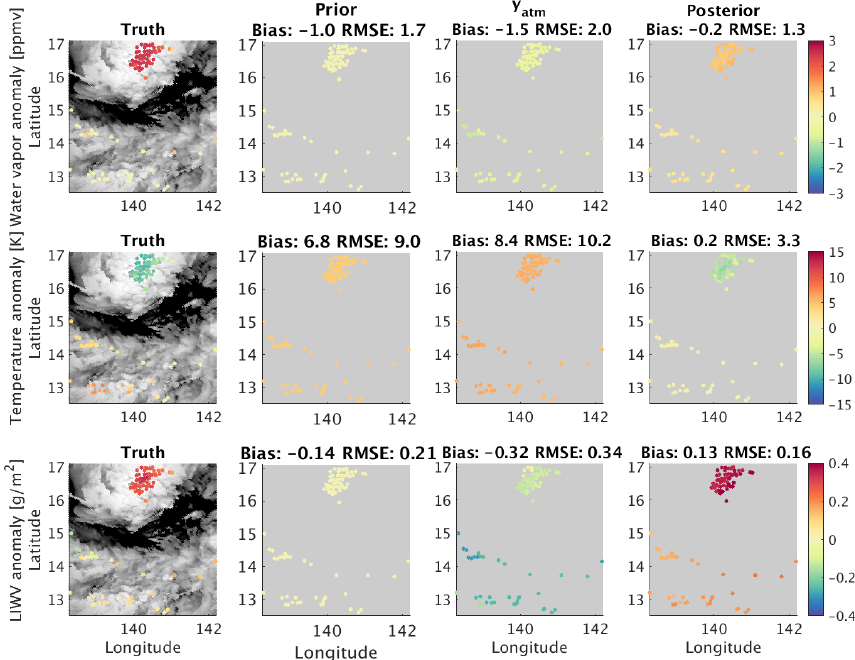
Figure A1. Horizontal distributions of the anomalies, defined as the deviation from the all-sky mean of the simulation field, in water vapor (in units of ppmv, upper panels), temperature (in units of K, middle panels) at 81hPa, and layer integrated water vapor between 110 and 70hPa (in the units of g/m 2 , lower panels). The truth fields are shown in the first column, with the background shaded in grey for BT 1231 . The other columns show the distribution in the prior, nearest ERA5 ( y atm ), and the posterior of the